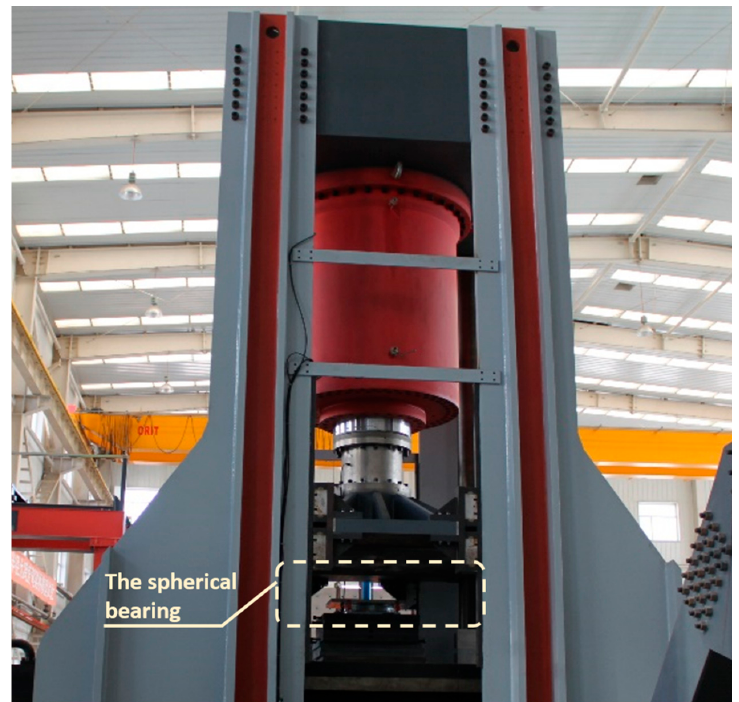
Figure 7. YAJ-30000 KN microcomputer controlled electro-hydraulic servo press shear test machine.